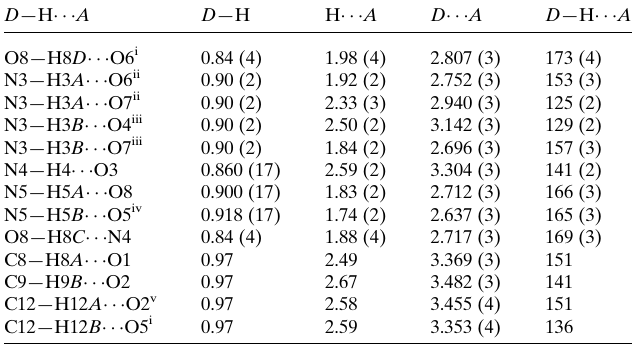
Table 1 Hydrogen-bond geometry (A˚ , (cid:4) ).